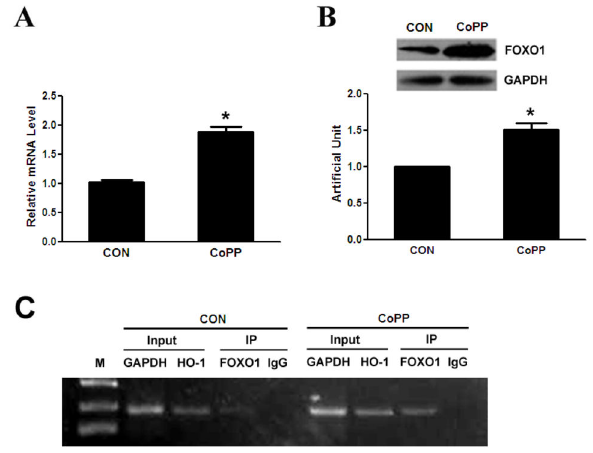
Figure 3. CoPP increases the expression of FOXO1 and promotes FOXO1 binding to the promoter of HO-1. Primary hepatocytes are treated for 16 h with and without 10µM of CoPP, after which cells are harvested. (A) HO-1 mRNA is quantified by qRT-polymerase chain reaction and relative amounts of FOXO1 mRNA are normalized to β-actin mRNA. (B) Protein levels are quantified by western blot as described in Methods and relative amounts of FOXO1 protein is normalized to GAPDH. (C) ChIP assay. Protein-DNA complexes are immunoprecipitated with anti-FOXO1 antibody or IgG. HO-1 promoter region harboring the FOXO1 recognition motif and control mGAPDH promoter are amplified by PCR. *p <